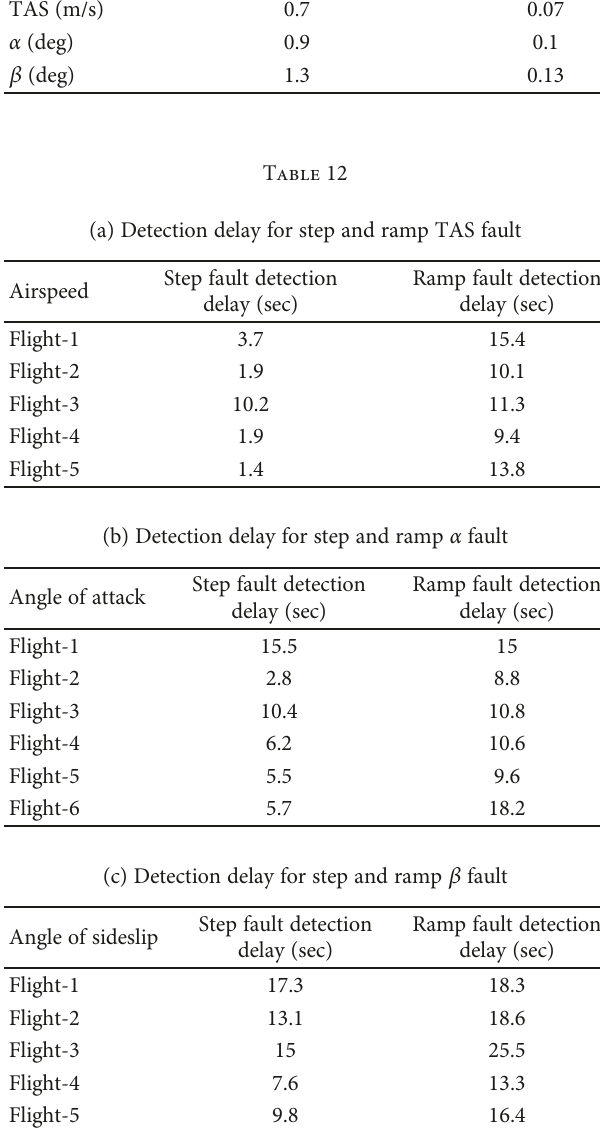
(a) Comparison between fi xed-threshold and